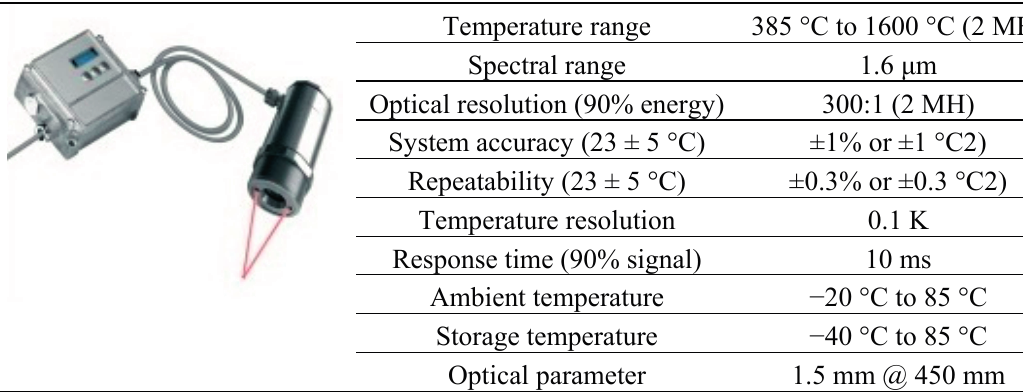
Table 3. Specifications of the IR (infrared radiation) pyrometer.